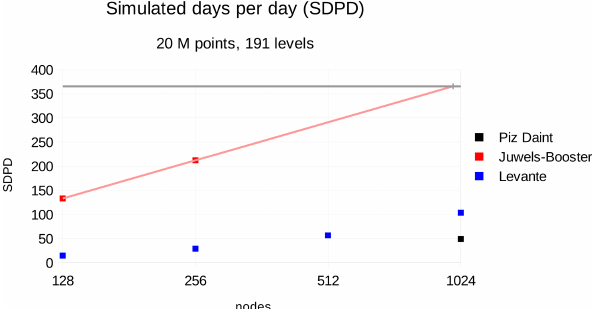
Figure 7. Simulated days per day R2B9 (20 M points) based on the integrate timer on Piz Daint, JUWELS Booster, and Levante. The black horizontal line indicates 1 simulated year per day. The thin red line is a linear fit in log(nodes) for the JUWELS Booster simulations. The vertical markers on the 1 sim. year per day line indicate the estimated number of nodes for the integration of a full year on JUWELS Booster: 984